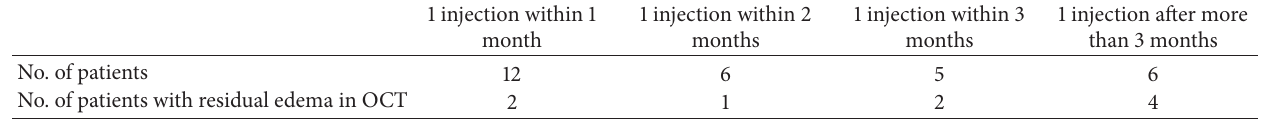
Table 3: Patients, timing of injections, and residual edema in OCT-1 injection group.